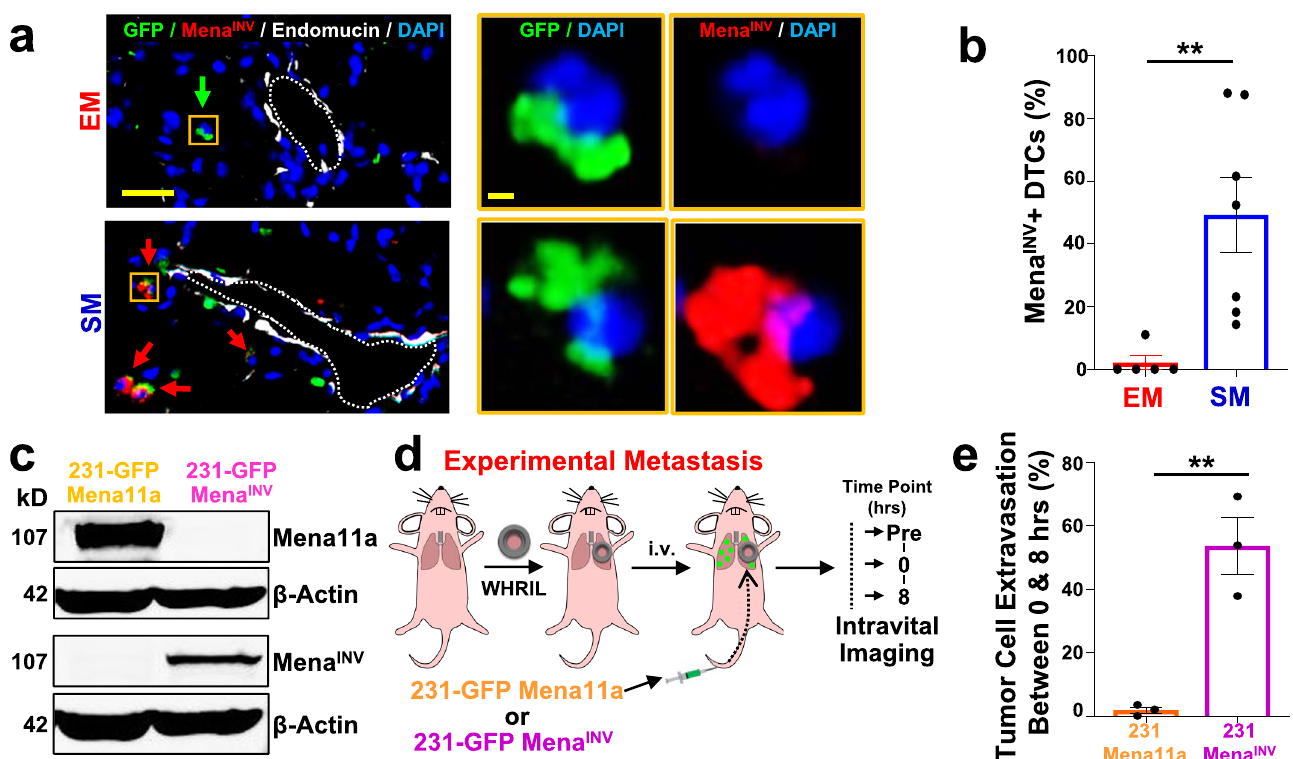
Fig. 2 Mena INV expression in disseminated tumor cells regulates extravasation ef fi ciency. a Left: Mena INV expression in extravascular E0771-GFP tumor cells in the lung of an EM model (top) and an SM model (bottom). Green arrow: Mena INV negative tumor cell. Red arrows: Mena INV positive tumor cells. Scale bar = 50 μ m. Right: Zoomed in view of a disseminated tumor cell (yellow box) in both models. Green = GFP, Red = Mena INV , White = endomucin, Blue = DAPI. Scale bar = 10 μ m. b Quanti fi cation of extravascular Mena INV positive disseminated tumor cells in the lung of each group from Fig. 2a. EM: n = 41 cells in 5 animals. SM: n = 89 cells in 7 animals. Bar = mean. Error bars = ±SEM. Two-tailed Mann-Whitney test ( p = 0.0025). ** p < 0.01. c Western blot of 231-GFP-Mena11a and 231-GFP-Mena INV cells. β -Actin was used as a loading control. Full blot is presented in Supplementary Fig. 16. d Outline of experimental design to determine percentage of tumor cells able to extravasate between 0 and 8 h after iv-injection. Intravital imaging of the lung vasculature through the WHRIL was performed before (Timepoint = “ Pre ” ), immediately after (Time point = 0 h), and then fi nally 8 h after tumor cell injection (Time point = 8 h). e Percentage of tumor cells that extravasated between 0 and 8 h after iv injection. 231-GFP-Mena11a: n = 90 cells in 3 mice. 231-GFP-Mena INV : n = 88 tumor cells in 3 mice. Bar = mean. Error bars = ±SEM. Two-tailed unpaired t -test ( p = 0.0048). ** p < 0.01. Source data are provided as a Source Data fi